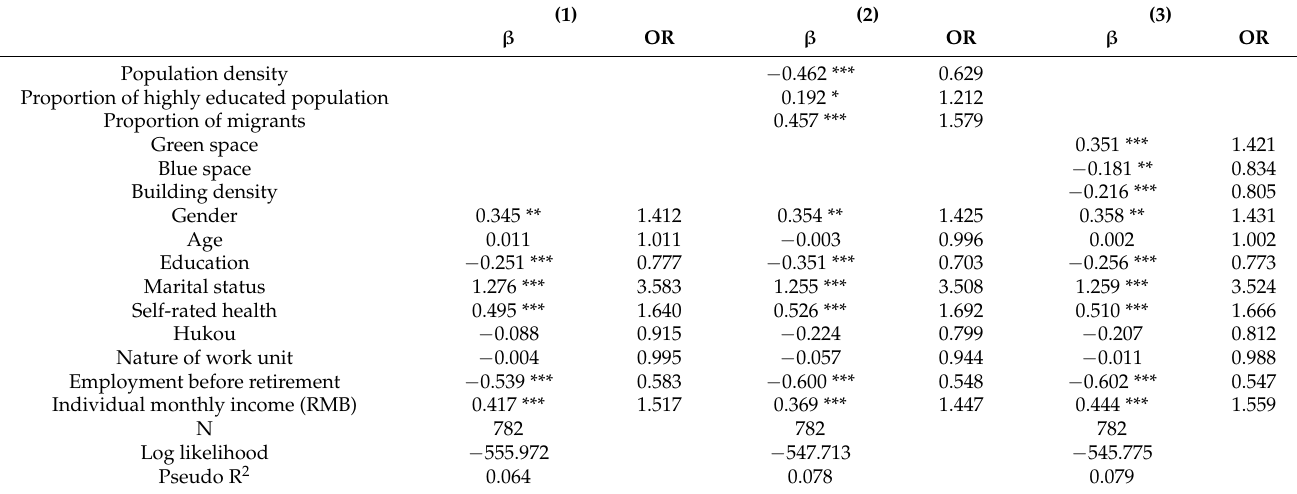
Table A1. The results of Ologit models of long-term residential environment exposure and subjective wellbeing in later